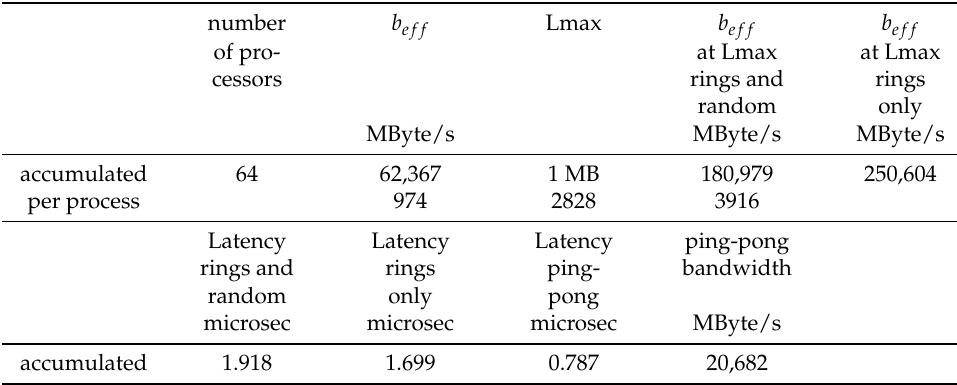
Table 3. Bandwidth with 64 core.